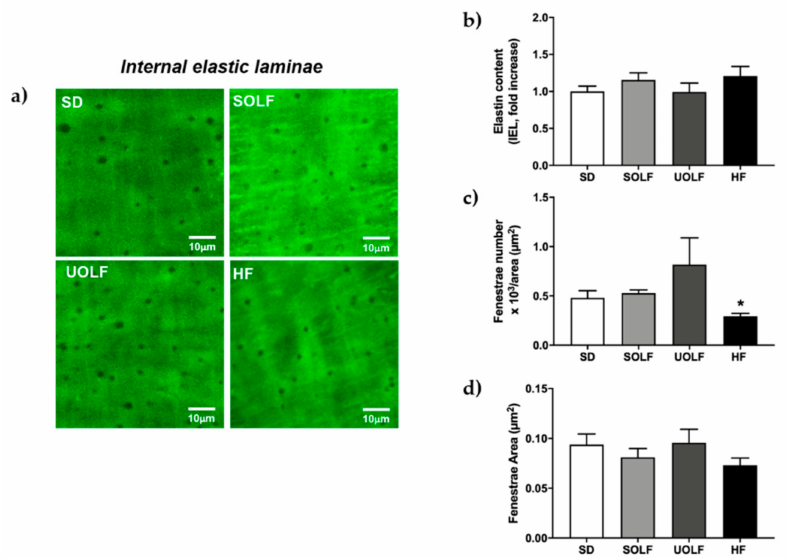
Figure 6. Elastin content and organization of internal elastic laminae (IEL) in first-order MRA. ( a ) Representative confocal microscopy images of projections of MRA’s IEL from SD, UOLF, SOLF, and HF mice. Projections were obtained from serial optical sections captured with a fluorescence confocal microscope (x63 oil immersion objective, zoom 2). Bar graphs show ( b ) fluorescence intensity, indicative of elastin content in the IEL, ( c ) fenestrae number, and ( d ) fenestrae area in MRA from SD, UOLF, SOLF, and HF animals. Results are expressed as mean ± SEM of n = 4–10. * p < 0.05 vs. the SD